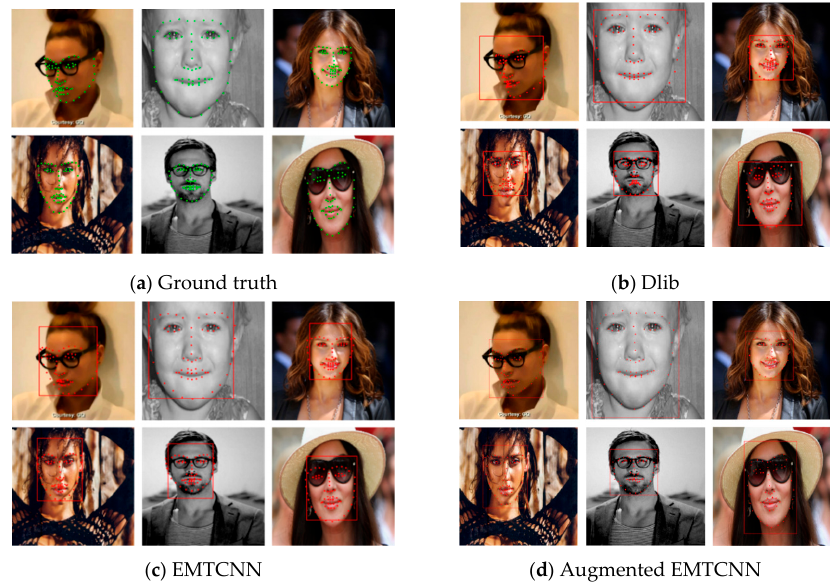
Figure 8. Comparison of facial landmark extraction results. Figure 7. Comparison of facial landmark extraction results.